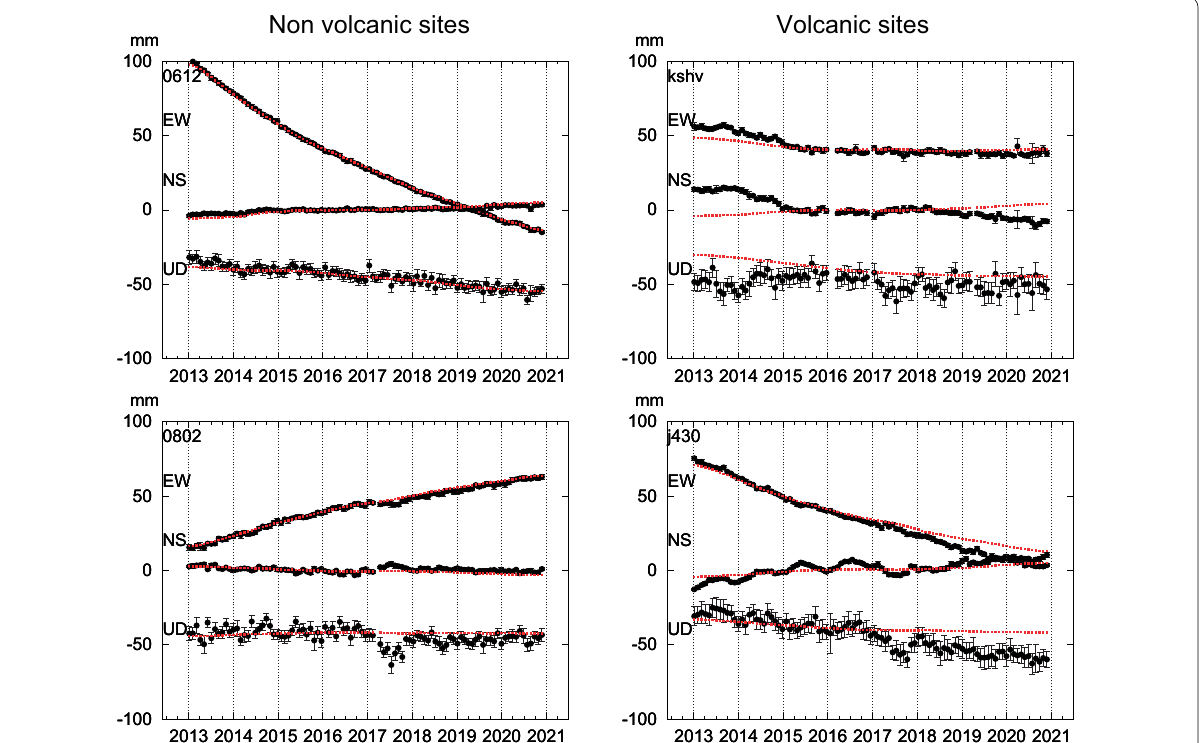
Fig. 3 GNSS coordinate time series and estimated tectonic deformation at selected sites. Black circles denote GNSS coordinate time series and solid red squares represent tectonic deformation estimated using Eq. (1). Error bars on black circles represent one sigma observation errors. Complete GNSS coordinate time series are given in Additional file 1: Figure S1a,